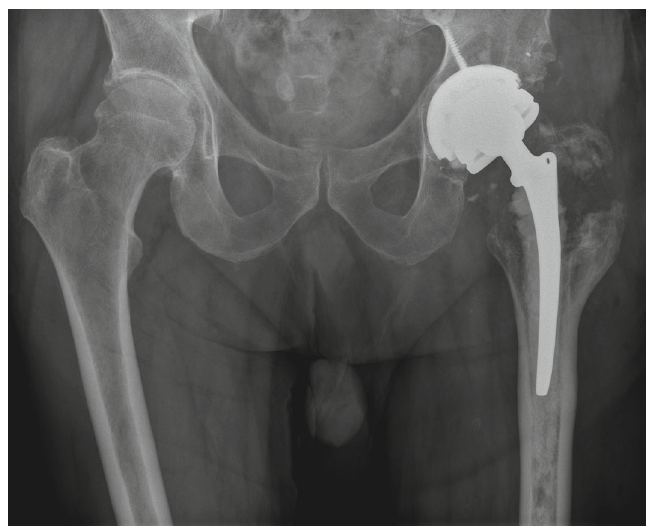
Figure 4: X-ray after the third revision surgery